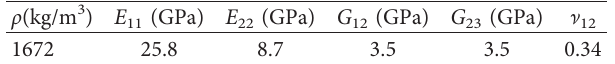
Table 1: Mechanical properties of carbon fiber/epoxy composite